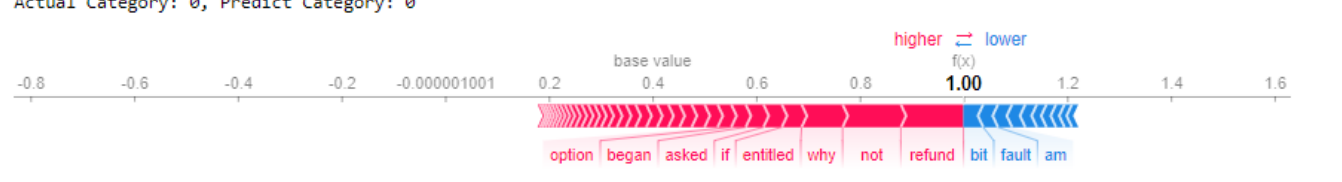
Figure 6. SHAP explanation of the positive customer review detected by the LSTM model.